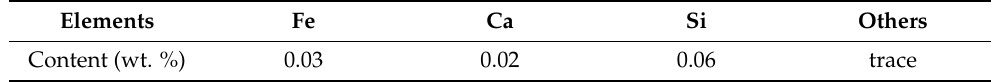
Table 2. Contents of main impurities in the crystalized oxalic acid phase. Elements Fe Ca Si Others Content (wt. %) 0.03 0.06